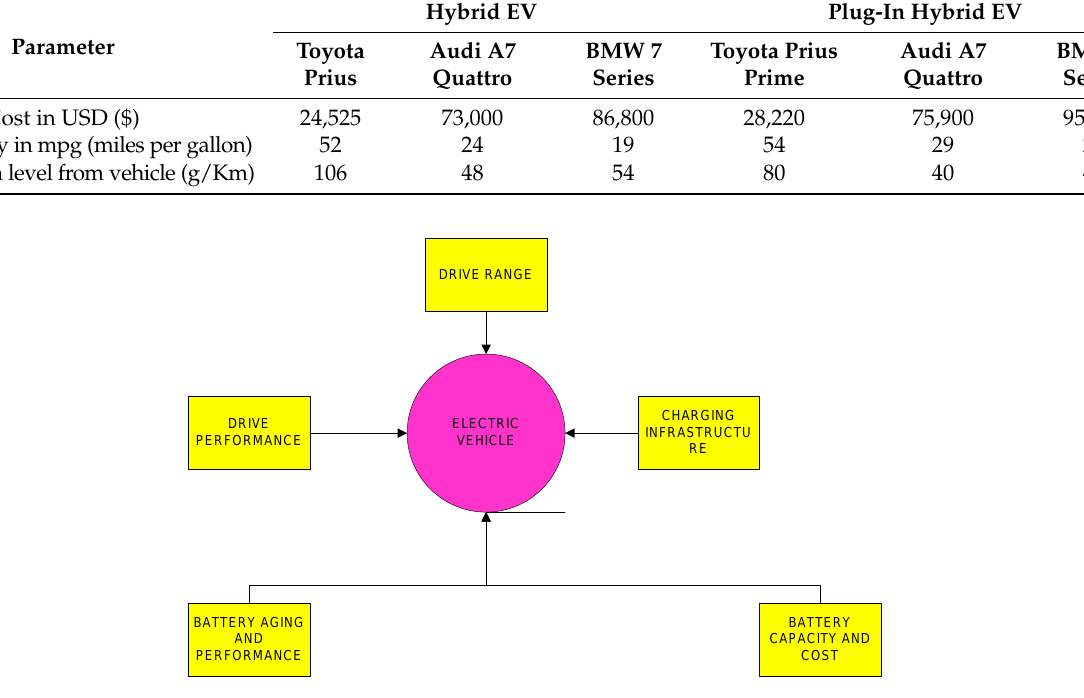
Figure 3. Parameters affecting EV overall performance.